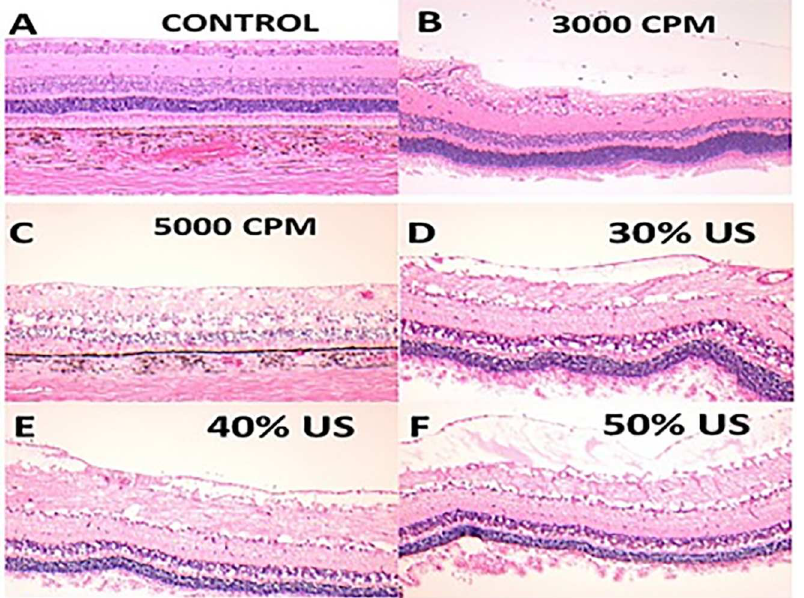
Fig 3. Hematoxylin-eosin stained horizontal retinal sections from porcine cadaveric eyes after pars plana vitrectomy procedures. (A) Section from a control eye without any procedure.(B and C) Retinal sectionsfrom eyes that underwent pars plana vitrectomy with a guillotinevitrector at 3000or 5000cuts per minute. ILM separation(B) and minimaldisintegrationat inner retinal layers (B, C). (D, E, and F) Retinal sectionsfrom eyes that underwent pars plana vitrectomy with a hypersonicvitrector at settings of 30% (D), 40% (E), and 50% (F) US power showingvacuolization, fragmentation of the nerve fiber and ganglioncell layers and inner limiting membraneseparation without any disruption.(A, B D and E) Sections from a open- sky vitrectomy procedures. (C and F) Sections from a closed vitrectomy procedure.